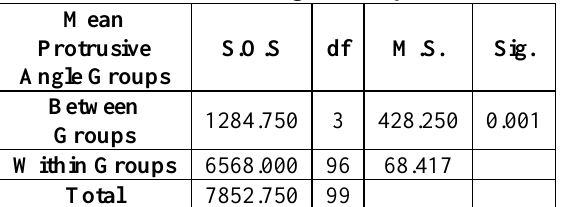
Table 2: ANOVA Test Results of the Mean Protrusive Angle